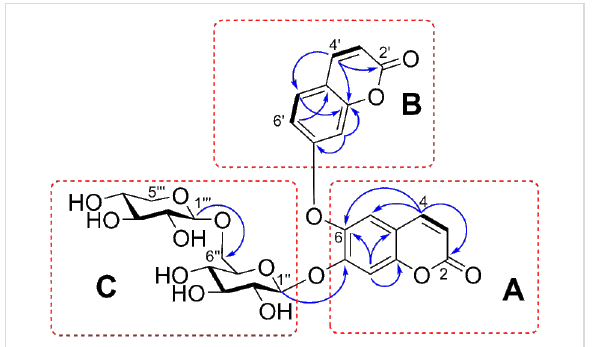
Figure 2: The key correlations observed in the 1 H- 1 H COSY (bold bonds), HMBC (blue) correlations of 1 (recorded in pyridine- d 5 , 600